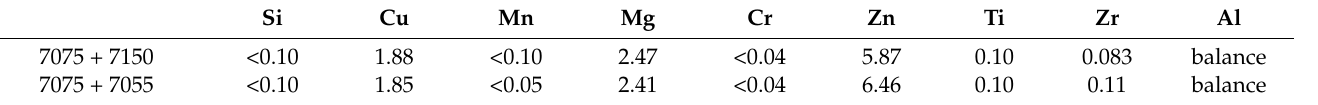
Table 3. Compositions of the welds.